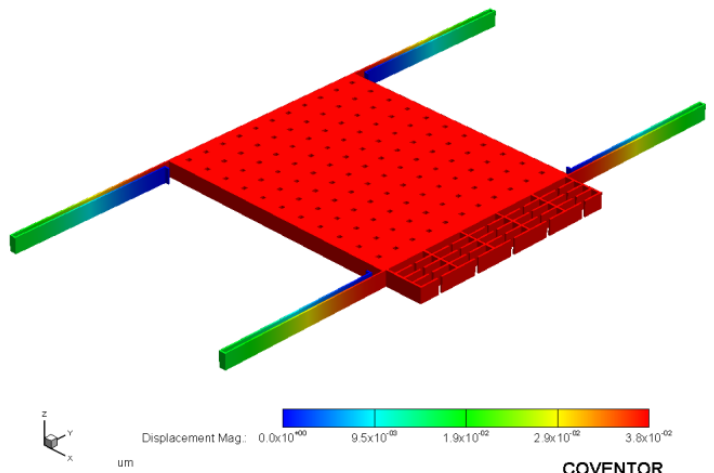
the experiment was9.4398 N/m and 5.1127 N/m, respectively. The relative errors from the